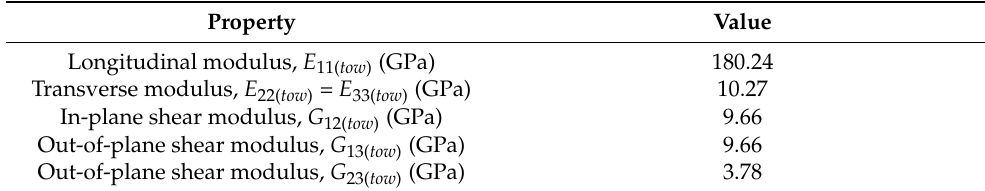
Table 5. Mechanical properties of the fiber tows in the T300/Cycom970 plain-woven fabric composite.